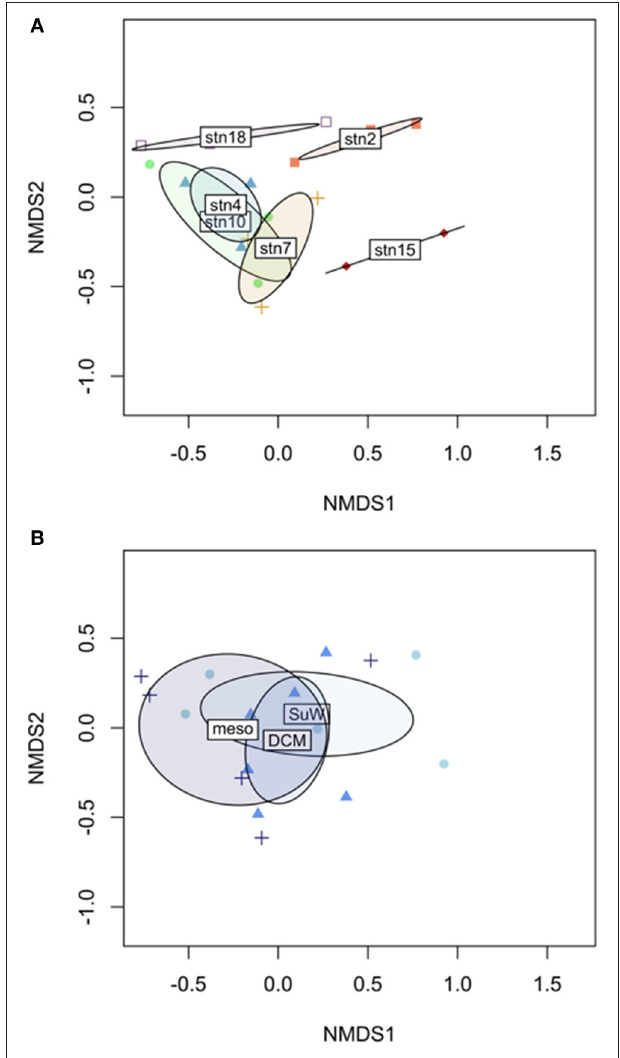
FIGURE 5 | Non-metric multidimensional scaling (NMDS) representation of Bray-Curtis dissimilarities of hydrolytic compositions among sampling sites in the upper 250m of the water column. Sites grouped by (A) station show significant hydrolytic compositional differences distinct from other stations (PERMANOVA P = 0.007), whereas the hydrolytic composition of sites grouped by (B) depth are not significantly different (PERMANOVA P =